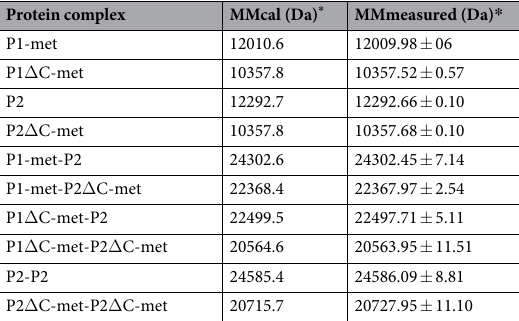
Protein complex MMcal (Da)